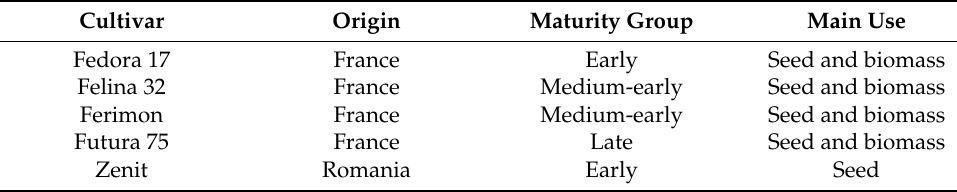
Table 1. Main characteristics of the five monoecious cultivars tested. Cultivar Origin Maturity Group Main